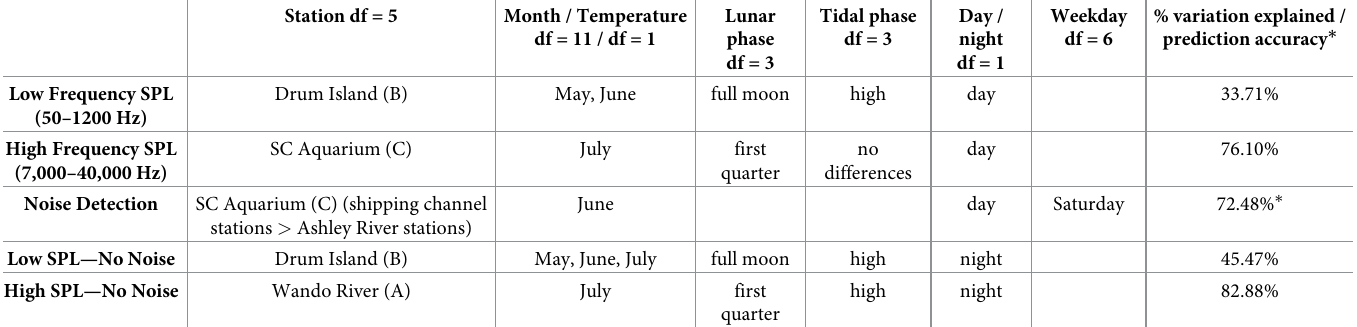
Table 1. Top ranked variable in each random forest model for low and high frequency root mean square (rms) sound pressure levels (SPLs), anthropogenic noise presence, and low (indicative of all fish calling) and high (indicative of snapping shrimp acoustic activity) frequency SPLs excluding noise files. Blank cells indicate that variable was not included in the associated model. Fig 2 shows the relative rank of each